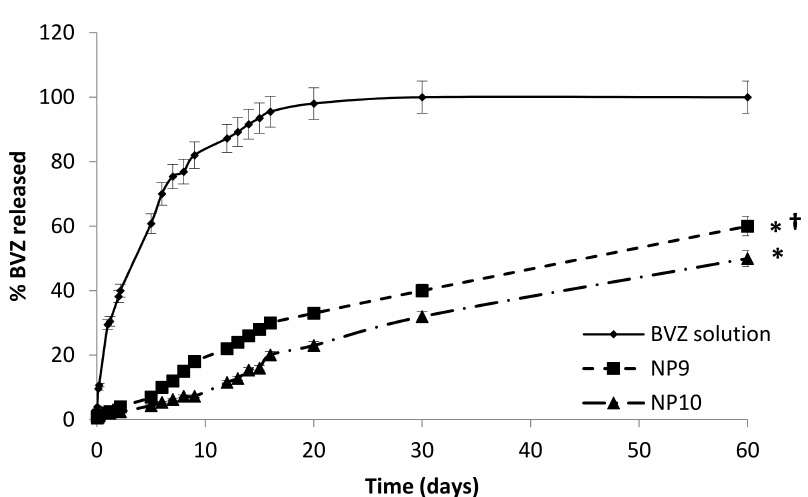
Figure 7. BVZ release profiles. Asterisks * refer to statistically significant differences of BVZ released from NP9 and NP10 vs. BVZ solution (* p < 0.05). The cross (†) refers to statistically significant differences of BVZ released from NP9 vs. NP10 († p <